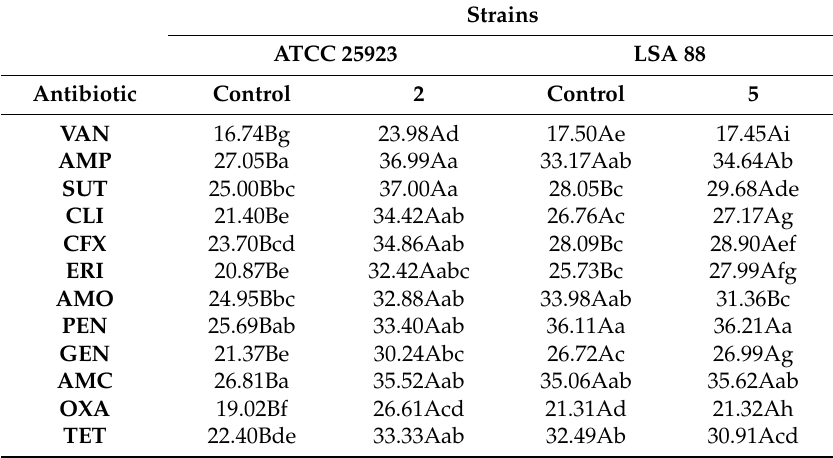
Table 4. Antibiogram (average halo diameter expressed in mm) of strains of S. aureus treated with amides derived from cinnamic acid and submitted to 12 different antibiotics. Assessed by agar gel diffusion method